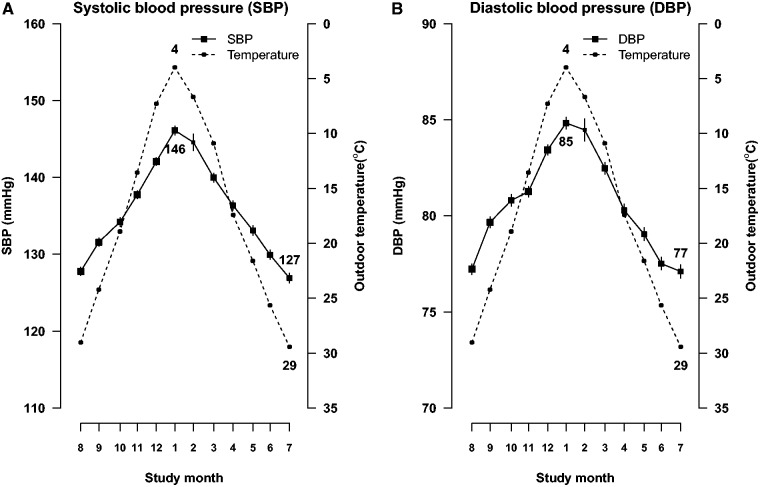
Mean (A) SBP, (B) DBP and outdoor temperature by study month. SBP, systolic blood pressure; DBP, diastolic blood pressure; CI, confidence interval. SBP and DBP values were adjusted for age, sex and education and plotted, along with mean monthly outdoor temperature, by the mean dates of survey in that month. Mean values and 95% CIs of blood pressure are shown in solid squares and vertical lines, with sizes of squares inversely proportional to the standard errors of the point estimates. Mean monthly values of outdoor temperature are shown in solid dots.